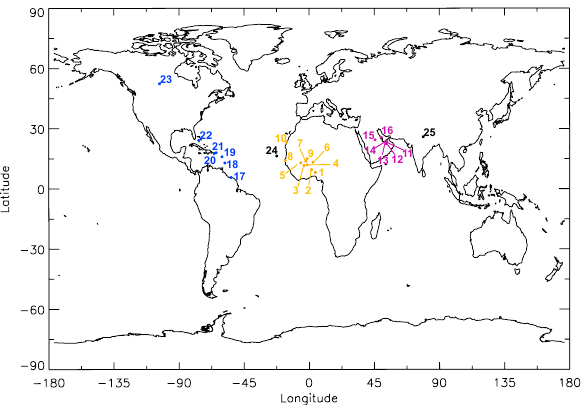
Fig. 8. Location of selected AERONET dusty sites based on the climatology built from the multi-annual database 1996–2006. Dusty stations are grouped regionally; Africa (orange), Caribbean- America (blue), Middle East (violet) and elsewhere in the world (black). Names and locations for each selected station are given in Table S3 in the